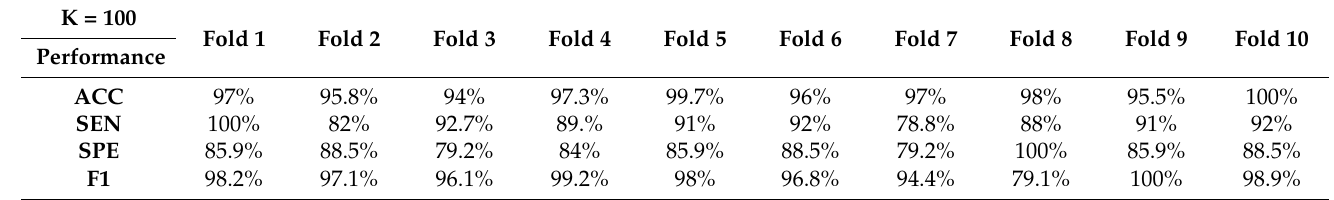
Table 6. The suggested method’s performance metrics after being subjected to ten-fold cross- validation with the RF classifier.